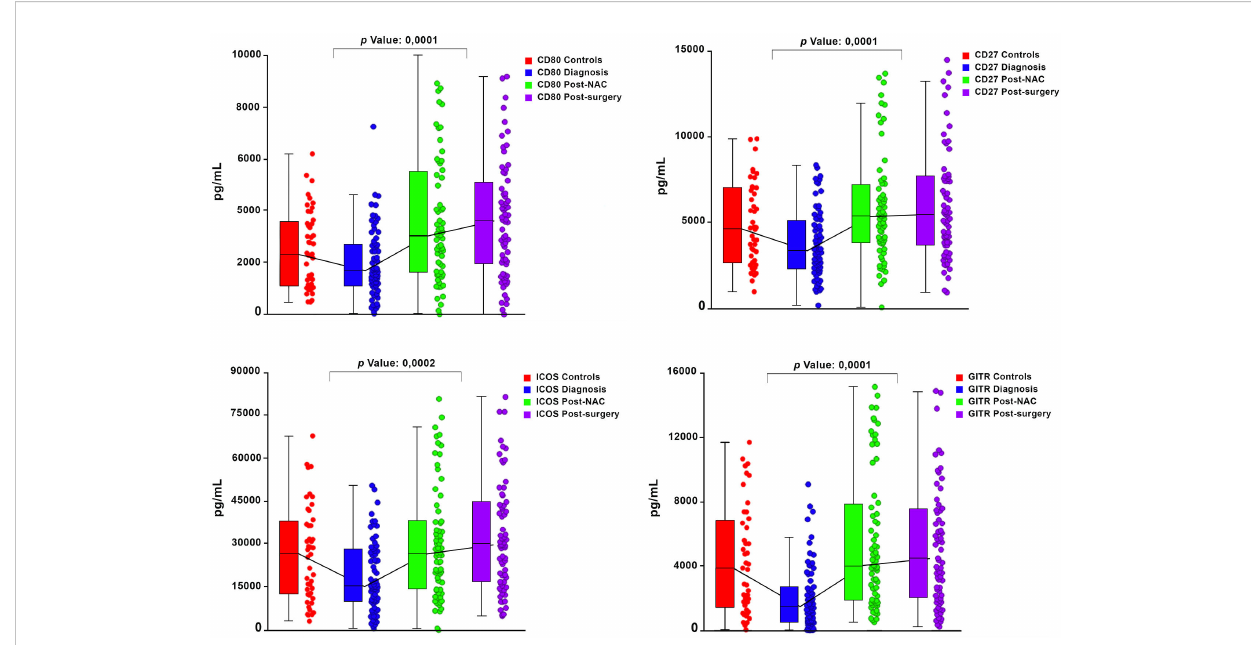
FIGURE 1 Box and whisker plots depicting the progressive changes in the median plasma concentrations (with 95% con fi dence limits) of four co-stimulatory immune checkpoints (CD27, CD80, ICOS and GITR) throughout the course of neoadjuvant chemotherapy (NAC) (pre-treatment/diagnosis, post- NAC and post-surgery) in relation to the corresponding median values of the control subjects. The p values represent the comparison between the pre-treatment/diagnosis and post-NAC